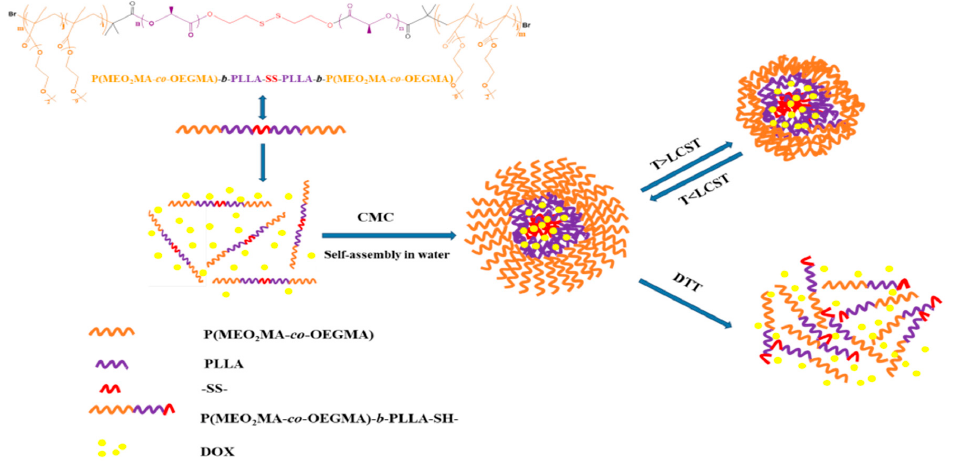
Figure 11. The schematic diagram of the self-assembly behavior of SPMO copolymers in water and the drug release of DOX-loaded micelles under different stimulation environments.